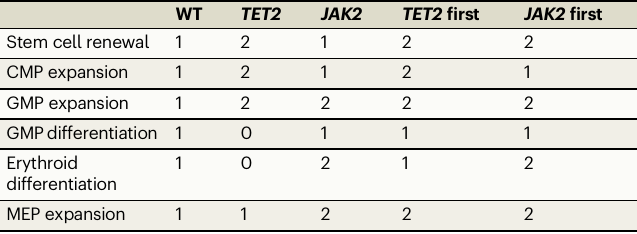
Table 1 | Speci fi cation table for JAK2 / TET2 BMA model WT TET2